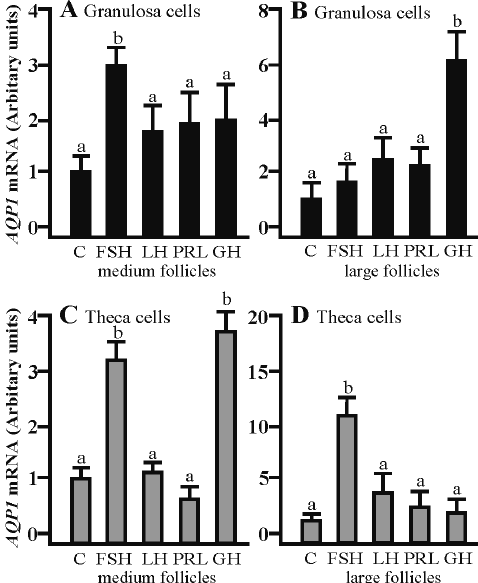
Figure 3. The expression of Aqp1 mRNA in granulosa and theca cells co-cultured in the presence of FSH, LH, PRL, GH in medium and large follicles. ( A , B ) the granulosa cells and theca cells ( C , D ). FSH, follicle-stimulating hormone; LH, luteinizing hormone; PRL, prolactin; GH, growth hormone. Values are expressed as means ± S.E.M from five separate experiments, each performed in triplicates ( p < 0.05 compared with controls). Statistically significant differences between treatments are indicated by different letters (a, b). C: control.